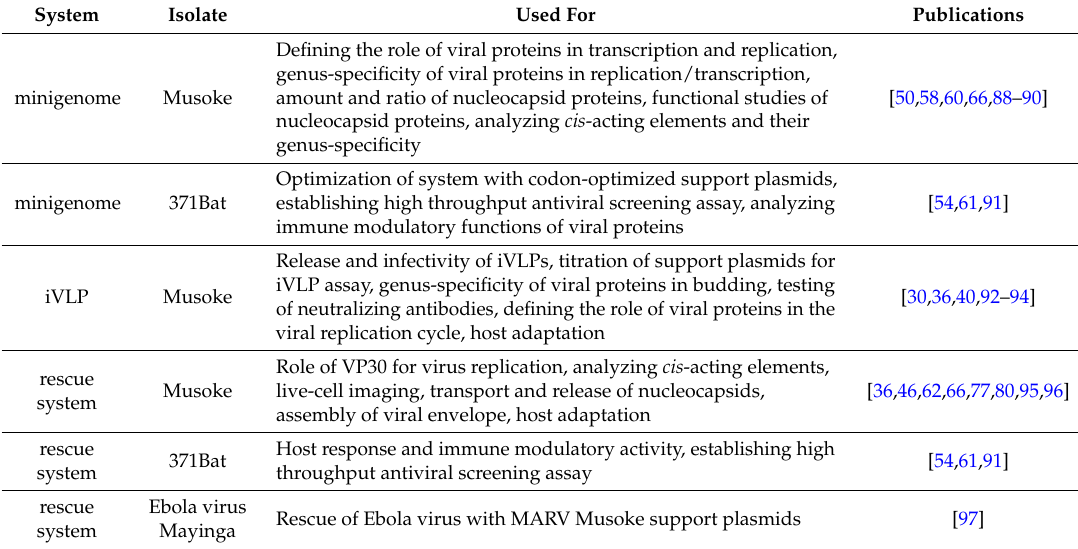
Table 1. List of Marburg virus (MARV) reverse genetics